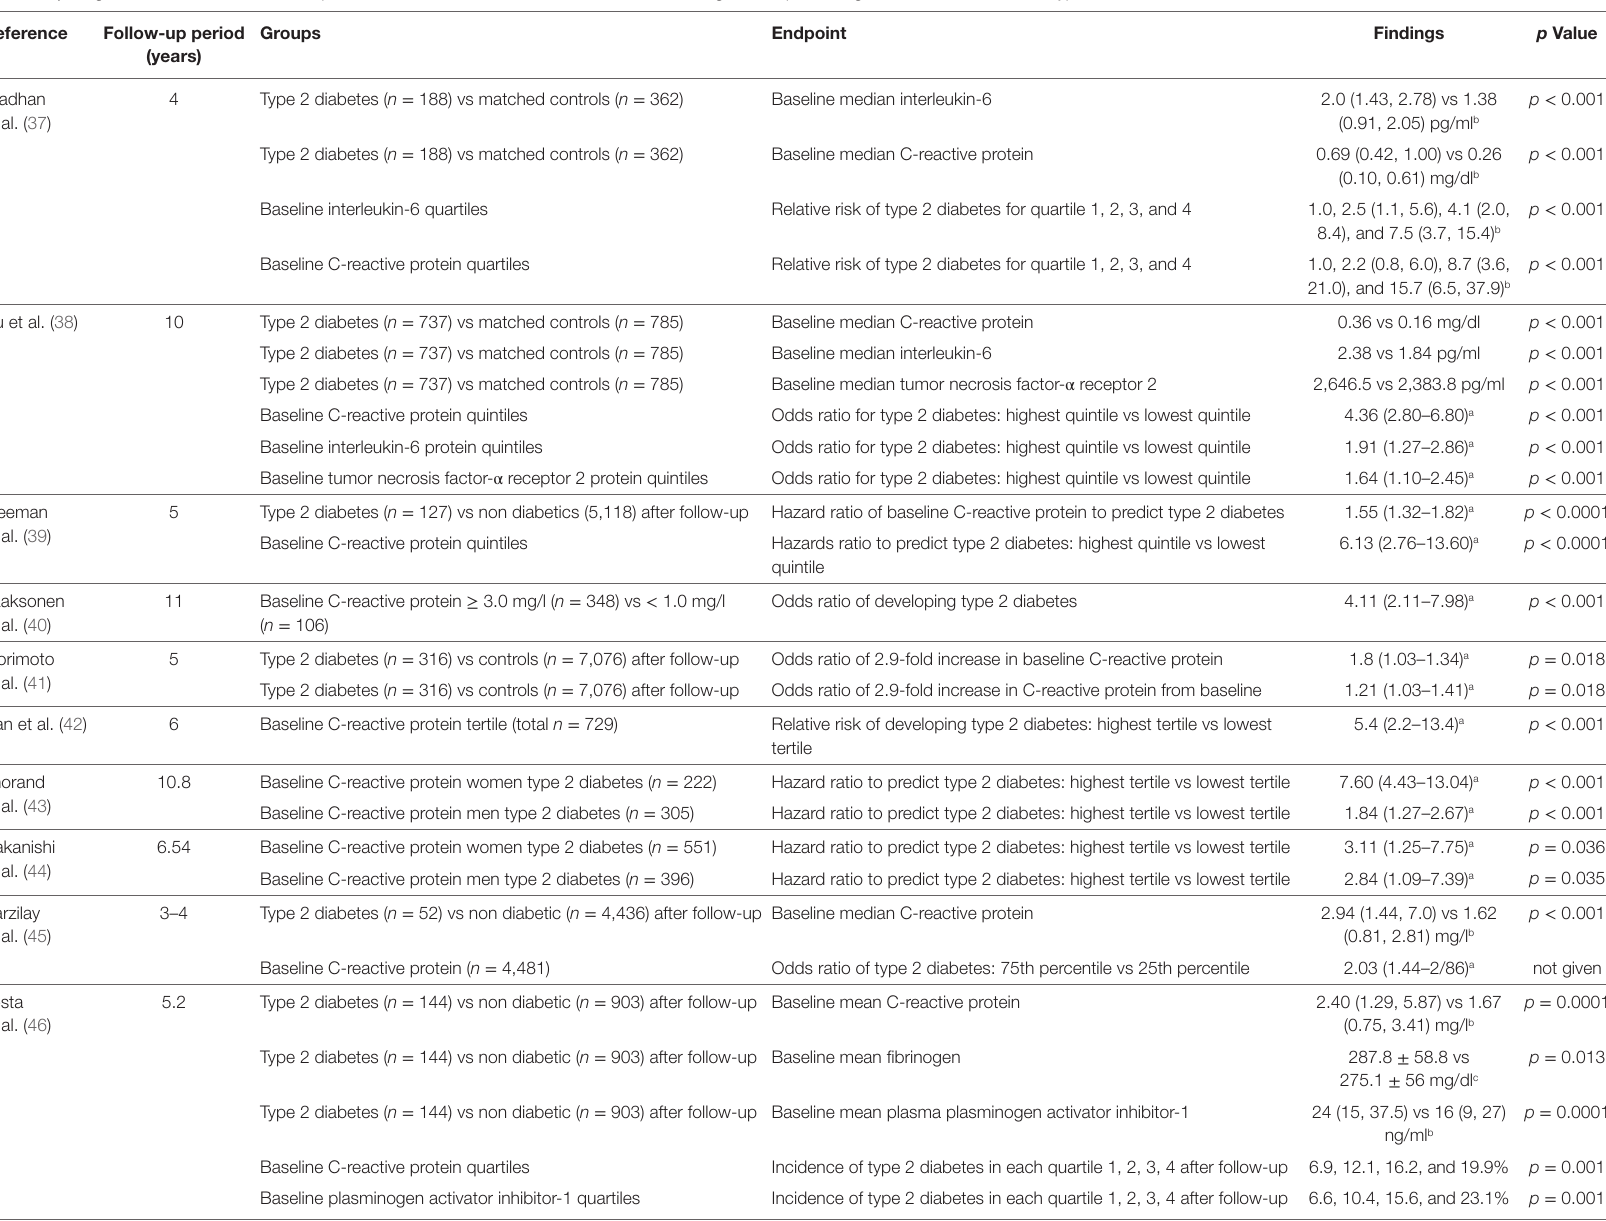
TABLe 2 | Longitudinal studies of C-reactive protein, interleukin-6, tumor necrosis factor- α , fibrinogen, and plasminogen activator inhibitor-1 in type 2